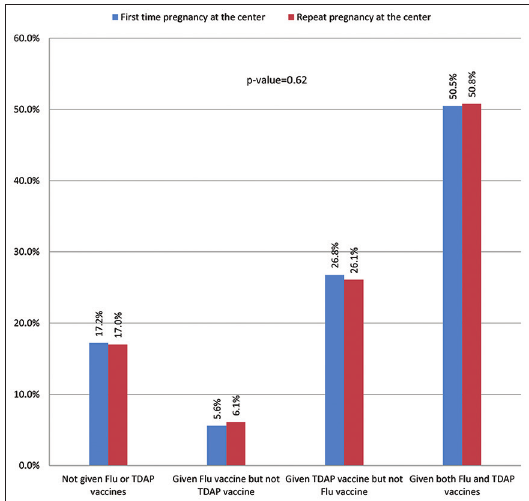
Figure 3 : Flu and TDAP vaccine acceptance by patient’s repeat pregnancy status at the center